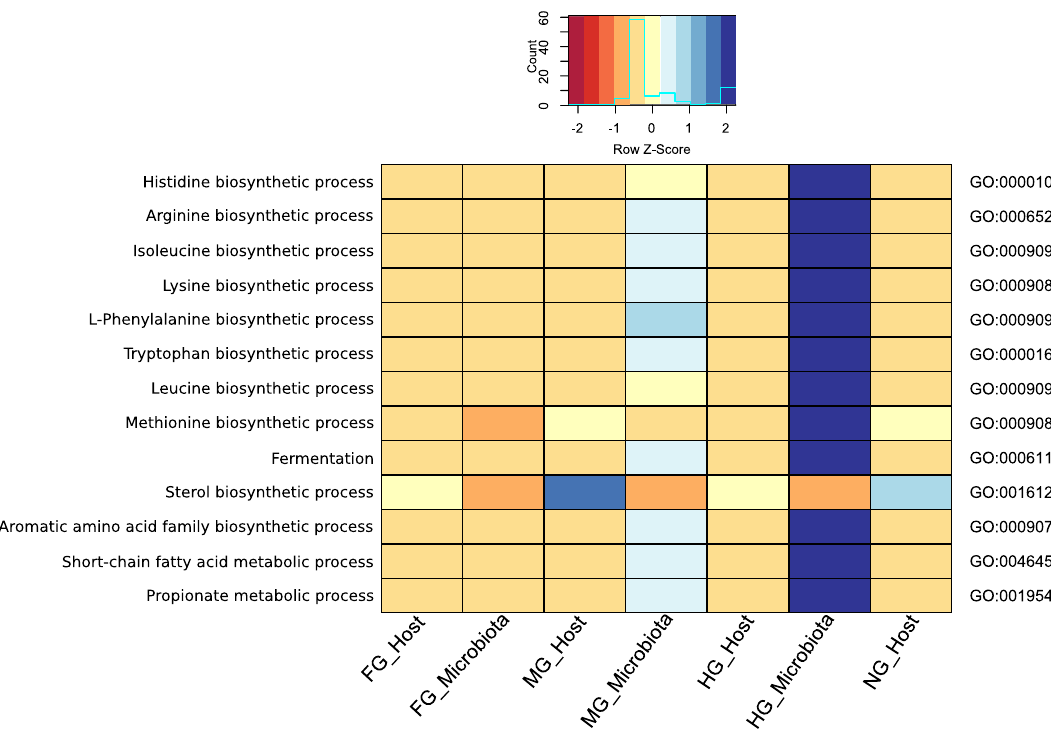
Figure 5. Heat map of the selected GO terms, especially amino acid biosynthetic processes in the assembled millipede holobiont. The colors of the scale bar denote the level of abundance on the Z-score, with dark blue and dark red indicating the highest and lowest level of abundance, respectively. The samples from foregut (FG), midgut (MG), hindgut (HG), and non-gut (NG) were